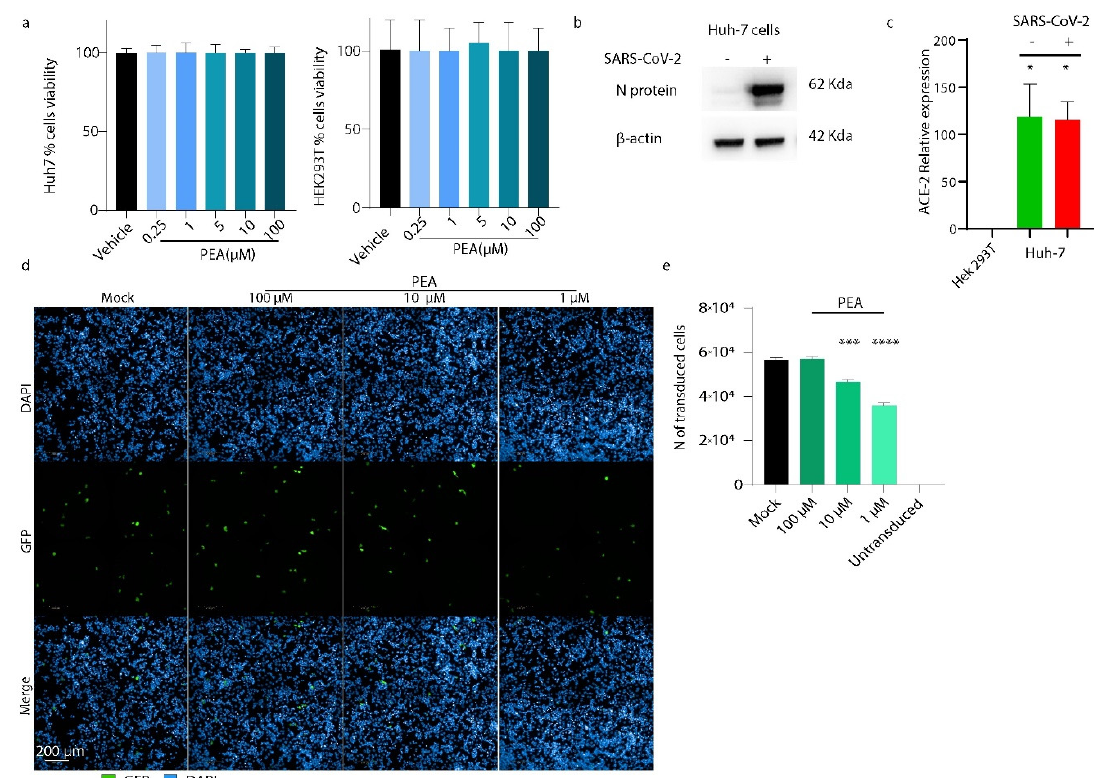
Figure 4. PEA decreases S-pseudotyped lentiviral vector transduction. ( a ) Cell viability assay per- formed on Huh-7 and 293T cells using WST-8 assay. ( b ) Western blot performed on Huh-7 cells, infected or not with SARS-CoV-2. ( c ) qRT-PCR performed on Hek293T cells and Huh-7 cells. The latter were infected or not with SARS-CoV-2. ( d ) High-content screening of transduced Huh-7 cells expressing GFP protein (green) treated or not with increasing concentrations of PEA. ( e ) Quantifi- cation of transduced cells. Around 40 fields were analyzed per well using a 63× water objective. Data are expressed as means ± SD and were analyzed using a one-way ANOVA (n = 3, * p < 0.5, *** p < 0.001, **** p < 0.0001).